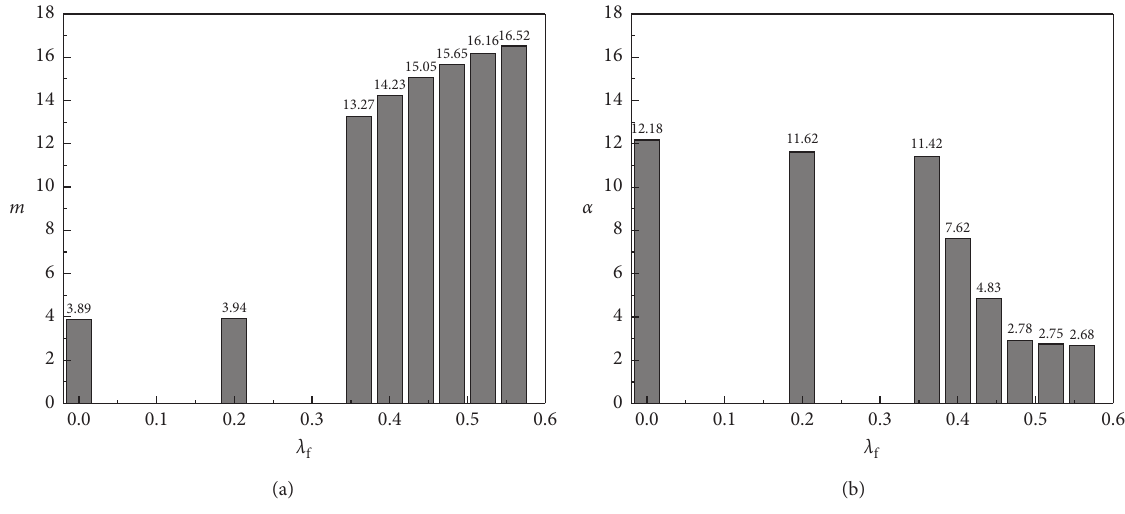
Figure 8: Relationship of λ f with (a) m and (b) α . Table 4: Key parameter of AASC with different steel fiber characteristic parameters.